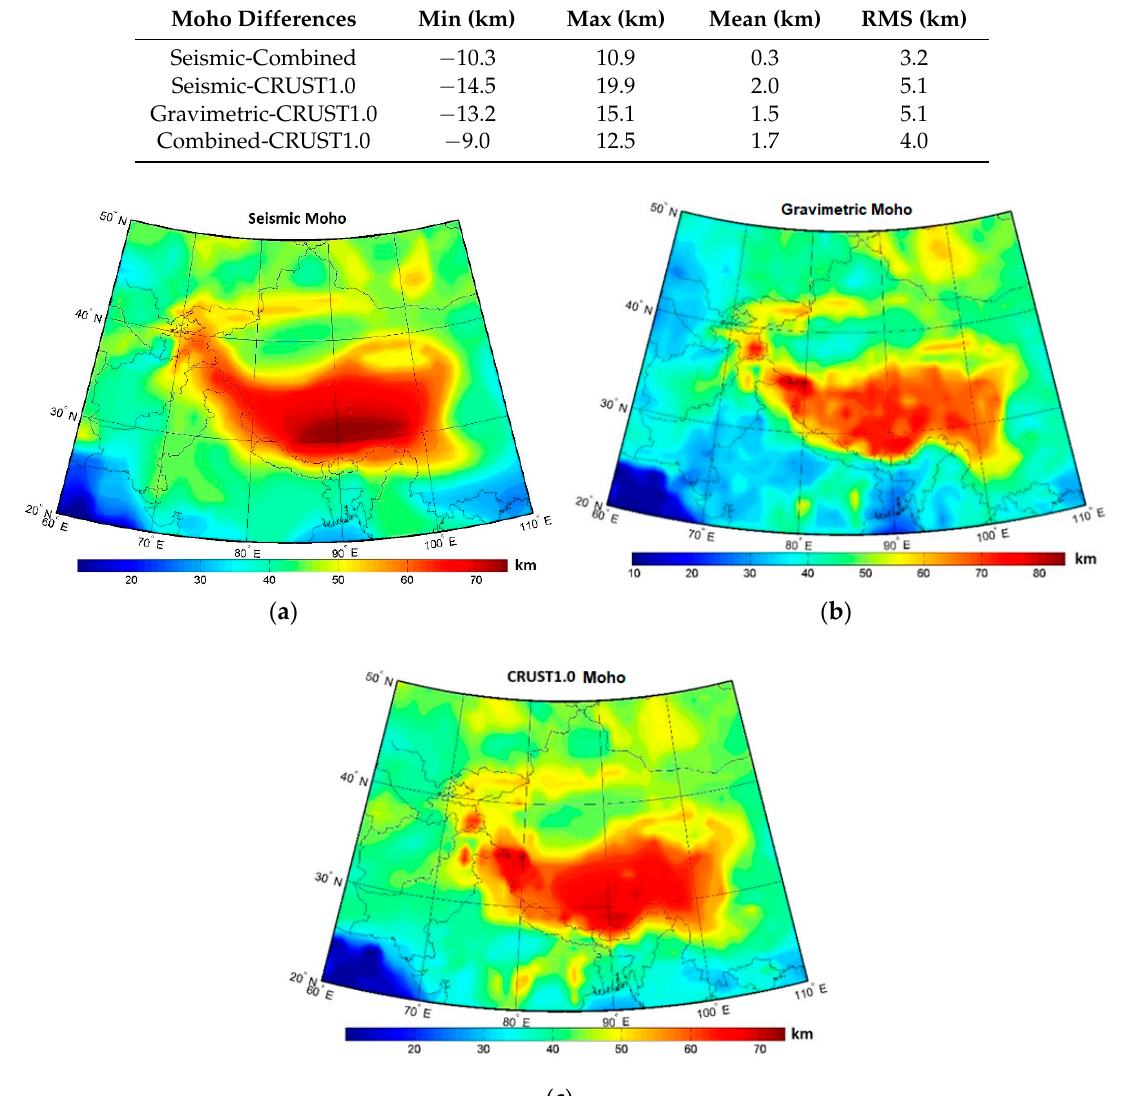
Figure 3. Moho models of Tibet: ( a ) seismic, ( b ) gravimetric, and ( c ) CRUST1.0.